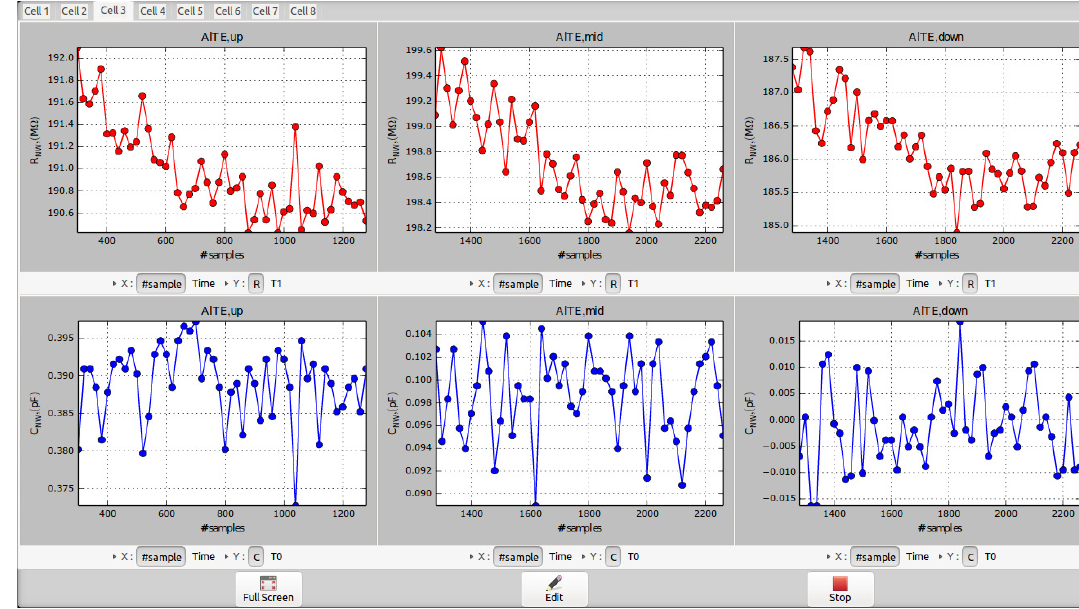
Figure 7. A screenshot of the developed graphical user interface needed for the real-time plot of the electrical properties (i.e., R NW , C NW ) of the assembled semiconductor